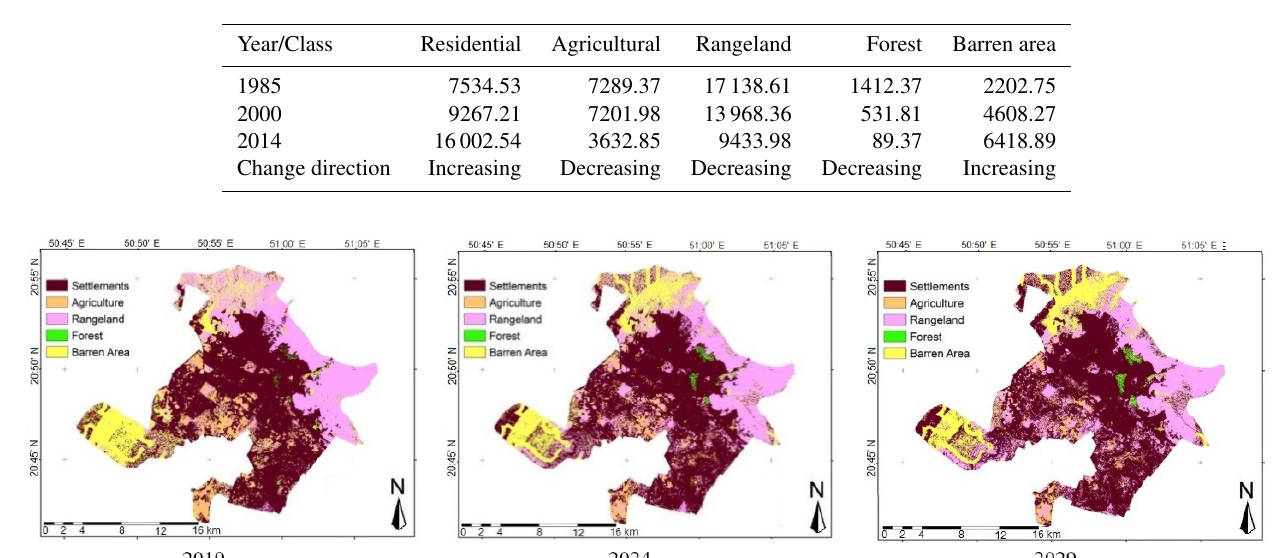
Table 4. Changes of land use/cover in the period from 1985 to 2014 (in hectares).